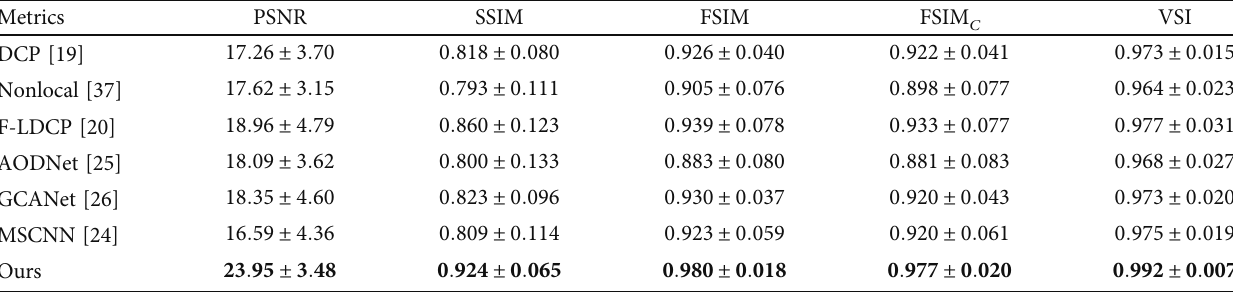
Table 1: Quantitate comparison on synthetic hazy images.